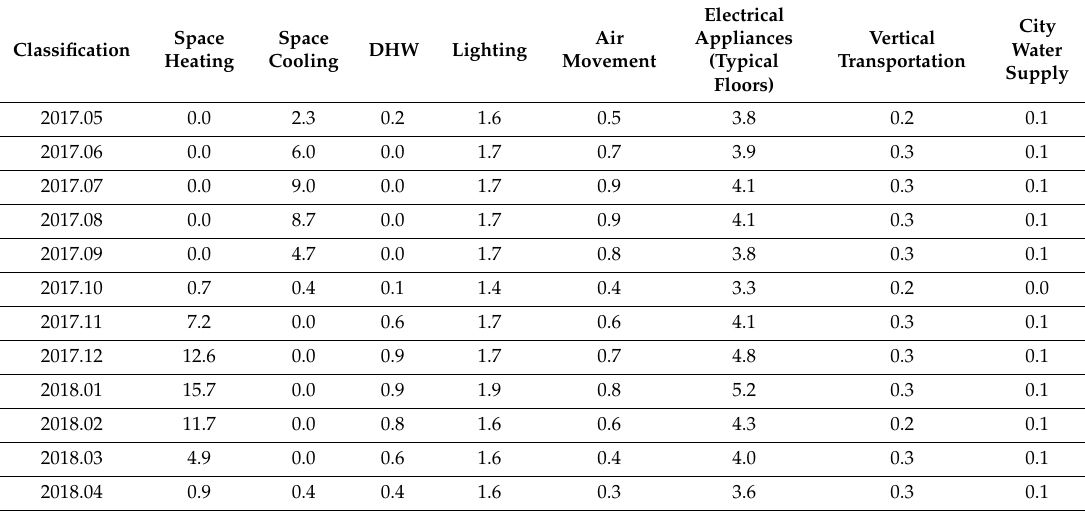
Figure 3. Monthly average outdoor and indoor temperatures distribution ( ◦ C). Table 15. Statistics of monthly site EUIs (kWh / m 2 ·